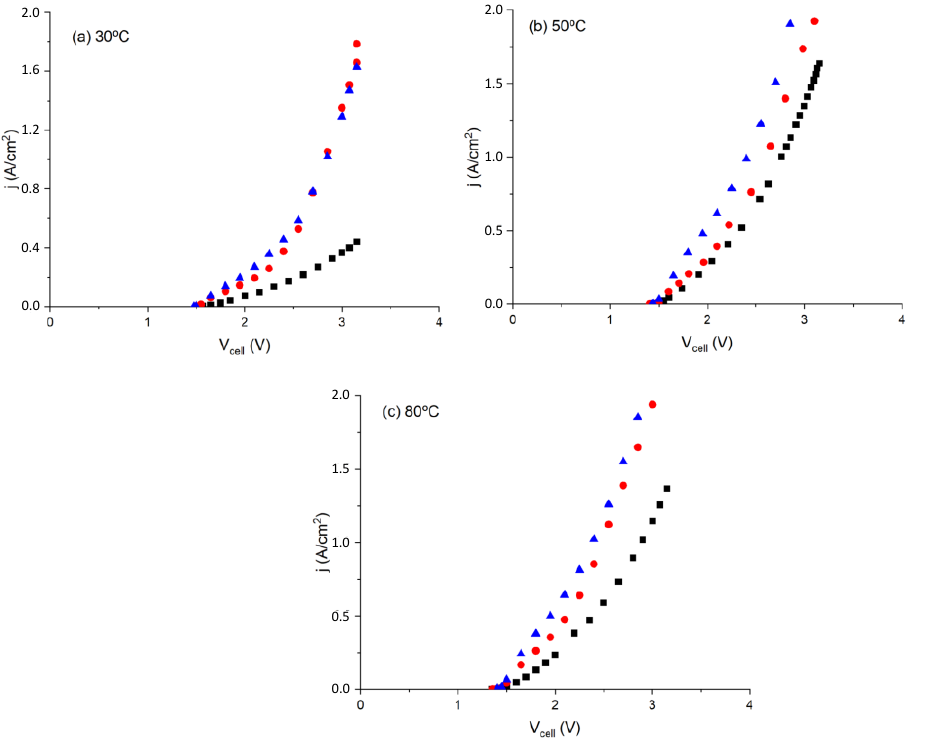
Figure 7. Polarization curves of MF-4SC ( ■ ), MF-4SC-PANI* ( ⬤ ), and MF-4SC-PANI** ( ) mem- branes at different temperatures.